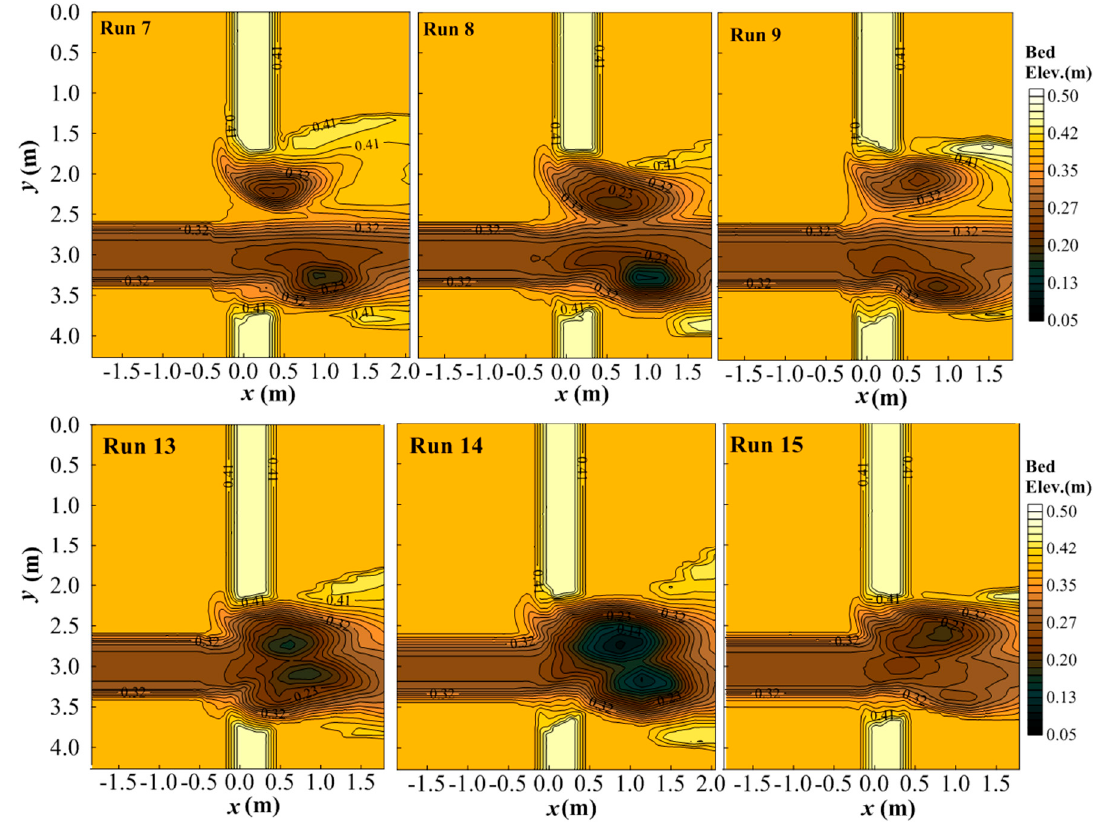
Figure 4. Contours for selected run in equilibrium condition.